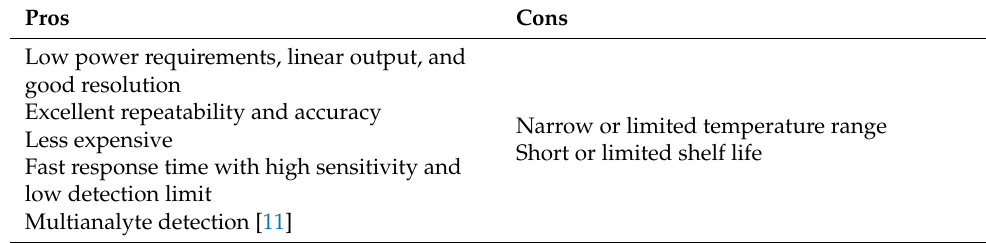
Narrow or limited temperature range Short or limited shelf